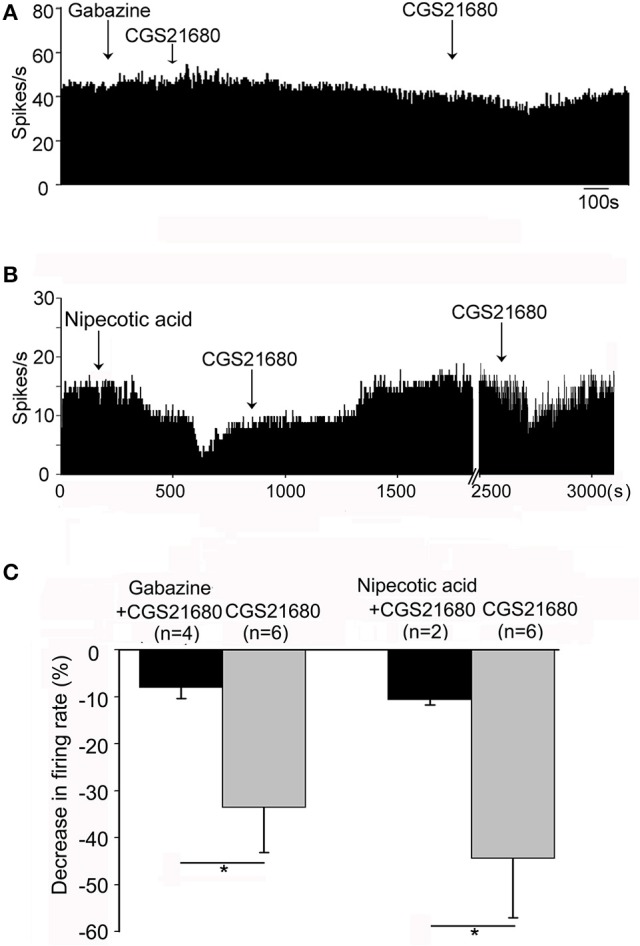
GABAergic transmission was involved in CGS21680-induced inhibition of the firing activity of globus pallidus neurons in normal rats. (A) Typical frequency histogram showing that 0.1 mM gabazine blocked CGS21680-induced decrease of firing rate of globus pallidus neuron. (B) Typical frequency histogram showing that in the presence of 10 μM nipecotic acid, CGS21680 did not induce clear decrease of firing rate. However, after long time recovery, the second time application of CGS21680 alone decreased the firing rate in the same neuron. (C) Pooled data summarizing CGS21680-induced decrease of firing rate in the presence (black bars) and absence (gray bars) of gabazine or nipecotic acid. *P < 0.05, Mann-Whitney test.